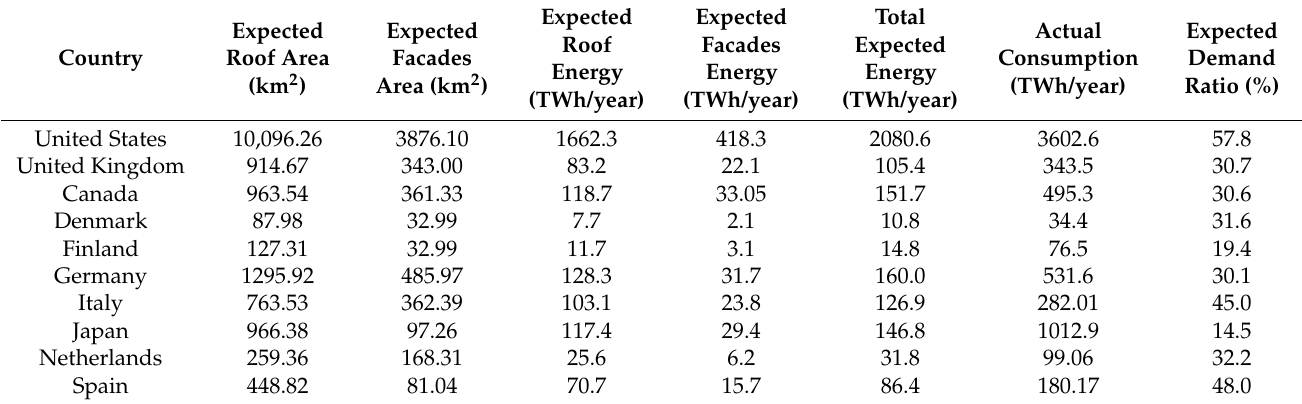
Table 1. The potential electricity generation capacity of BIPV for selected countries of the International Energy Agency [63].